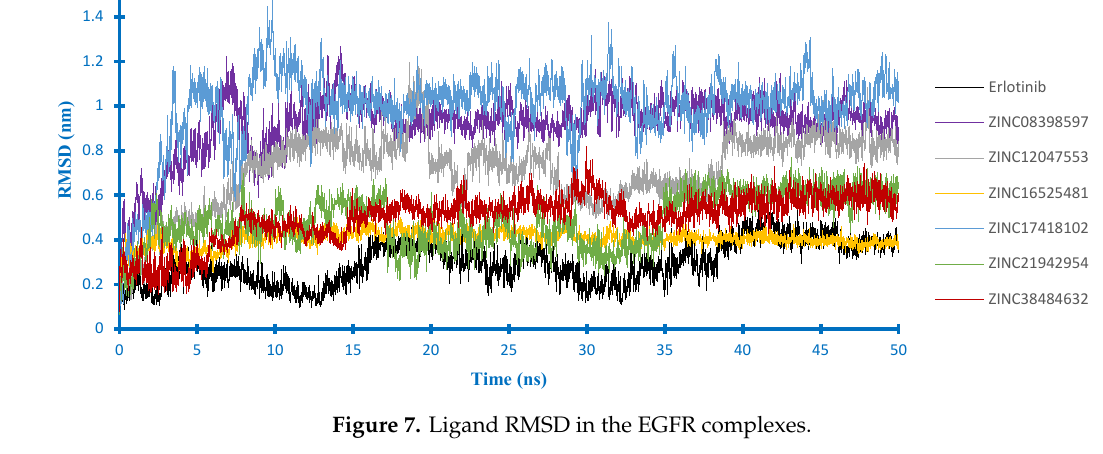
Figure 6. Backbone RMSD of the VEGFR2 complexes.